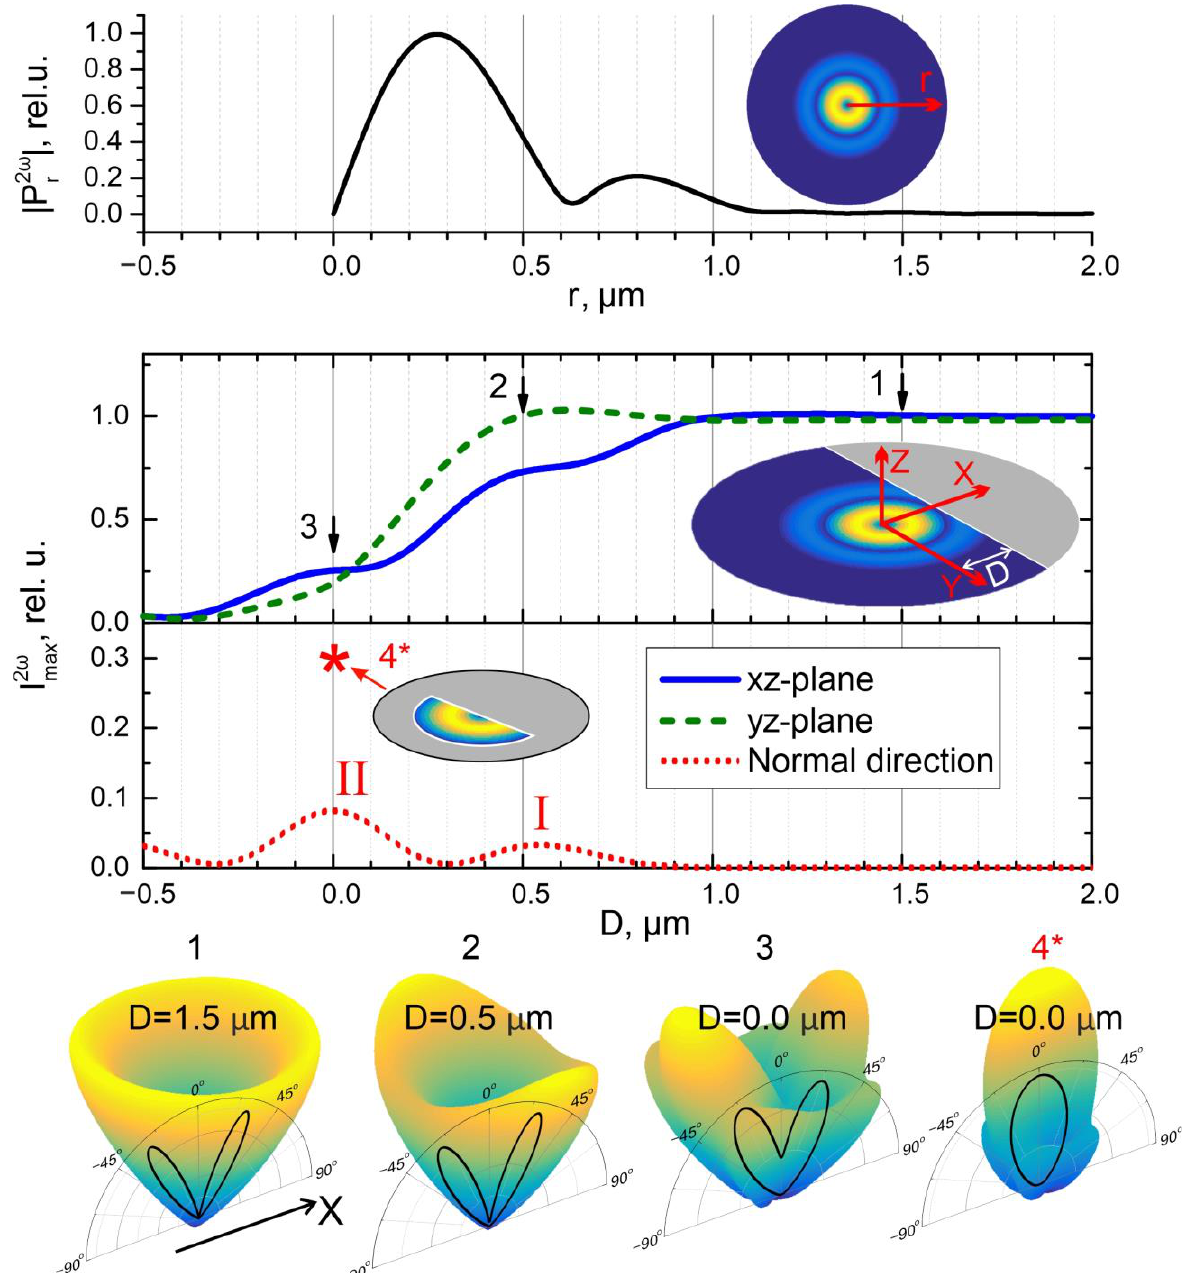
Figure 5. Upper row : radial profile of the distribution of nonlinear polarization (| P r 2 ω |) at the surface possessing χ (2)xzx -component of the second order susceptibility and excited by a radially polarized beam; inset: 2D-map of polarization. Middle row : Maxima of the intensity of the SH radiation in xz - (solid curve) and yz -planes (dashed curve) and intensity in the normal direction (dotted curve) vs. distance between the beam center and the edge of the nonlinear region ( D ); the axis and D are designated in the inset; negative D corresponds to the beam center falling over the edge. Lower row : second harmonic radiation patterns for D = 1 .5 μm (1), D = 0 .5 μm (2), D = 0 .0 μm (3) , and D = 0.0 μm (4*) with an addition radial confinement of nonlinearity (see corresponding inset 4*); overlaying curves: cross-sections of RPs in the xz -plane.